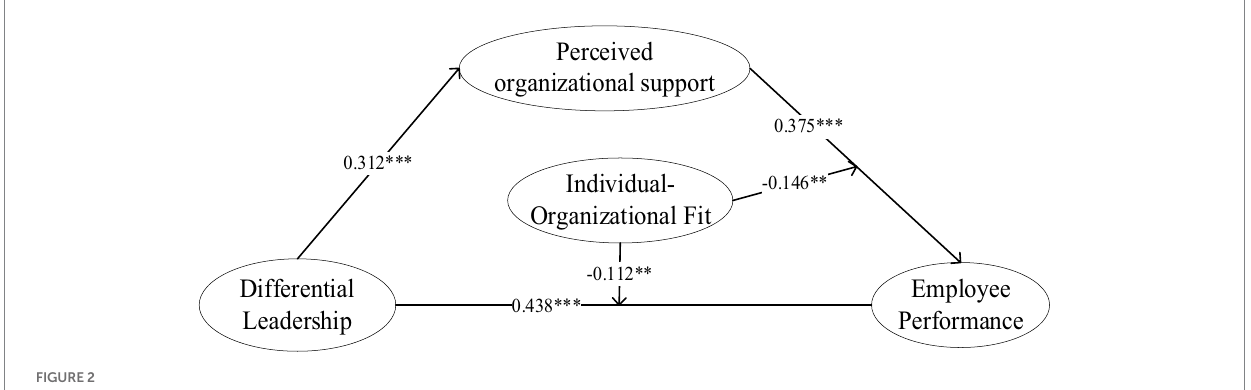
FIGURE 2 Hypothesis testing results. * p < 0.05, ** p < 0.01, *** p < 0.001.